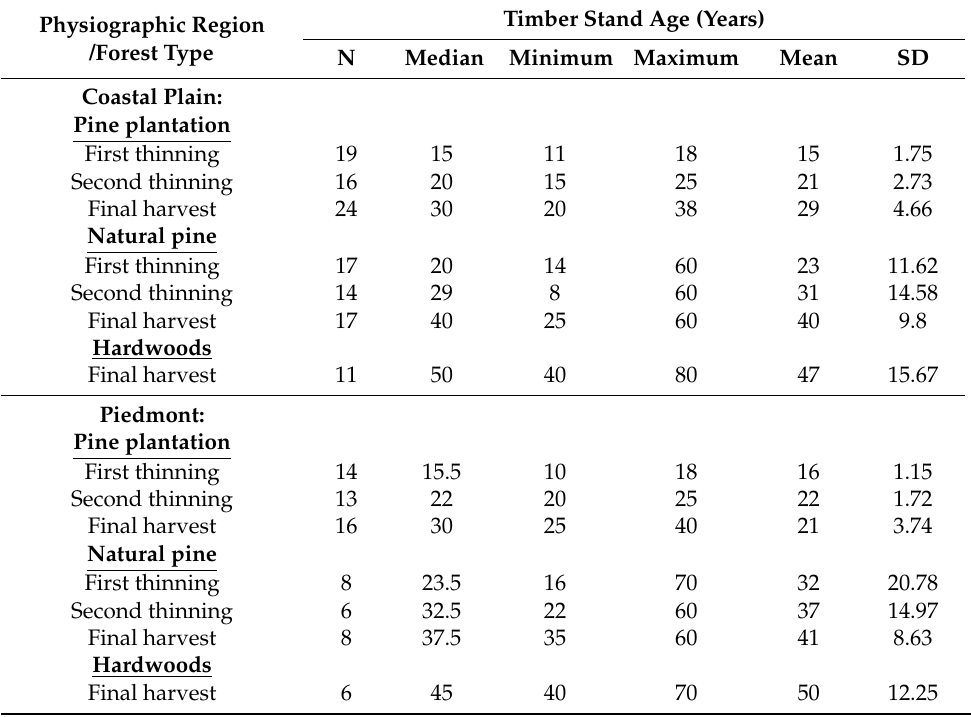
Table 2. Rotation and thinning ages by region, forest type, and stand origin. Physiographic Region /Forest